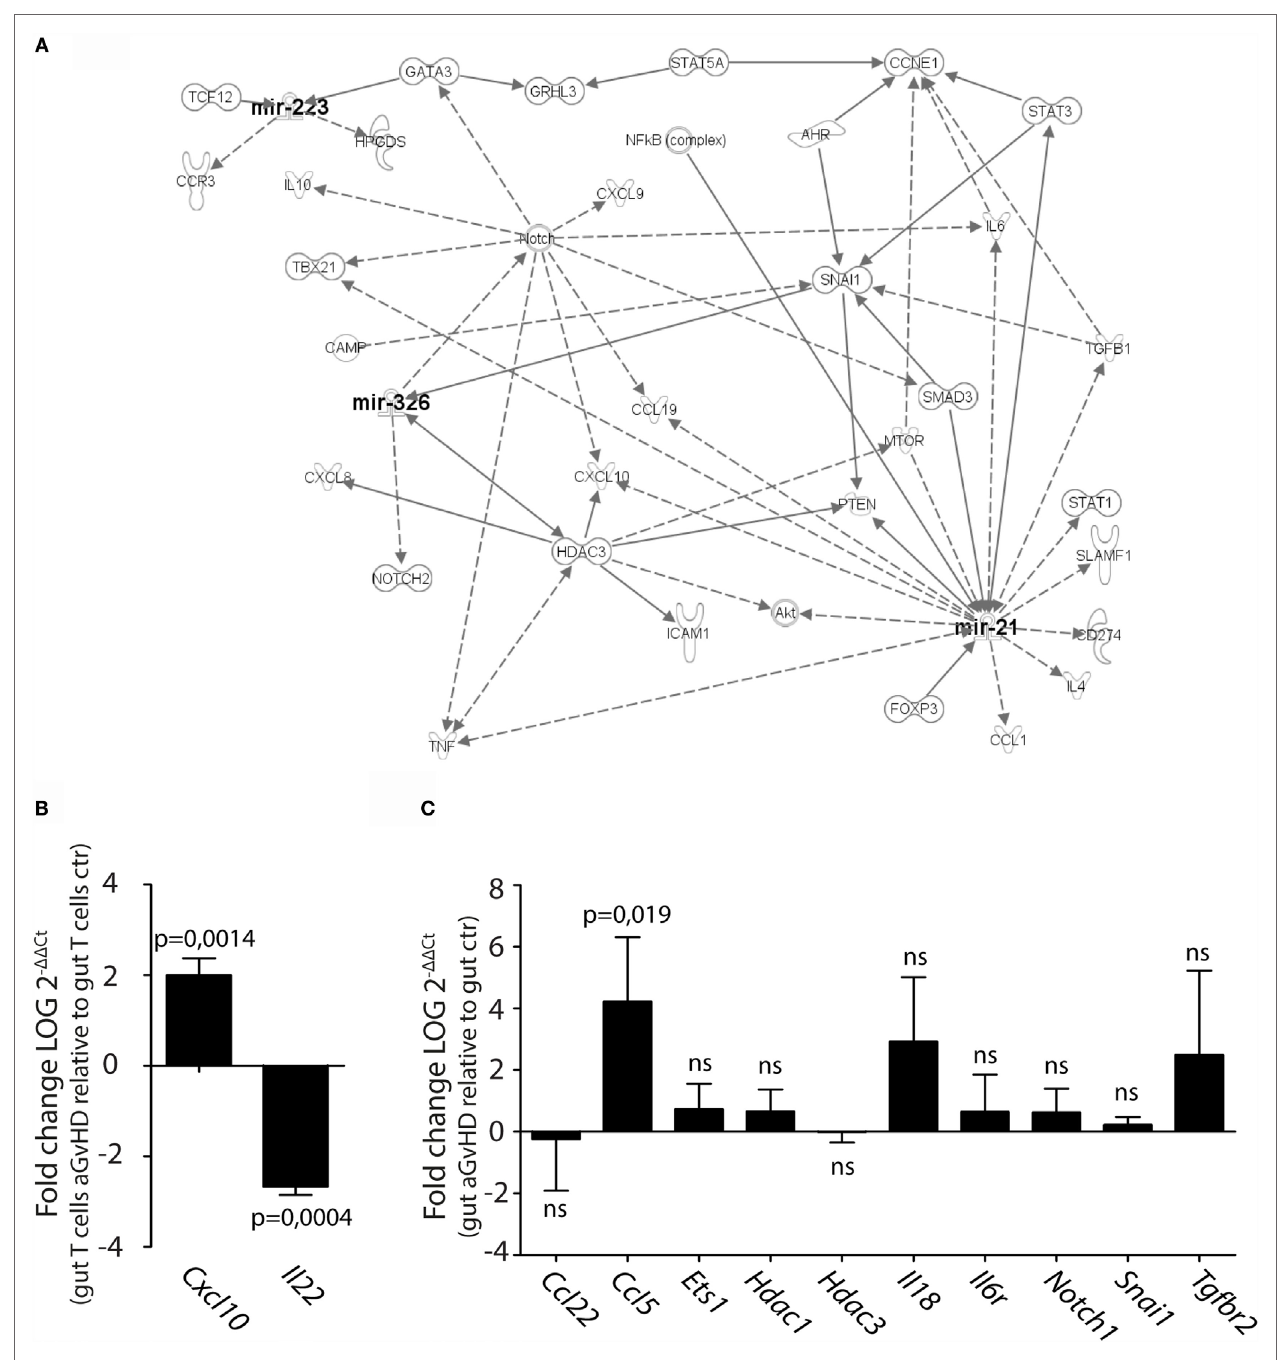
FigUre 7 | iPa network analysis of differentially expressed mirnas in intestinal tissue and T cells . (a) A network of possible mRNA targets and affected biological pathways for miR-21, miR-223, and miR326 was constructed using QIAGEN’s IPA software. Dashed lines represent indirect interactions, while solid lines indicate direct interactions. (B,c) mRNA expression analysis by qRT-PCR analysis of (B) intestinal T cells from controls ( n = 3) or aGvHD rats ( n = 3) or (c) intestinal tissue from controls ( n = 6) or aGvHD rats ( n = 6). Samples were normalized to endogenous control ( B2m ) and expression levels reported as log of 2 −ΔΔ Ct ± SD. Significance was calculated using the Student’s t -test (two-tailed) with Welch’s